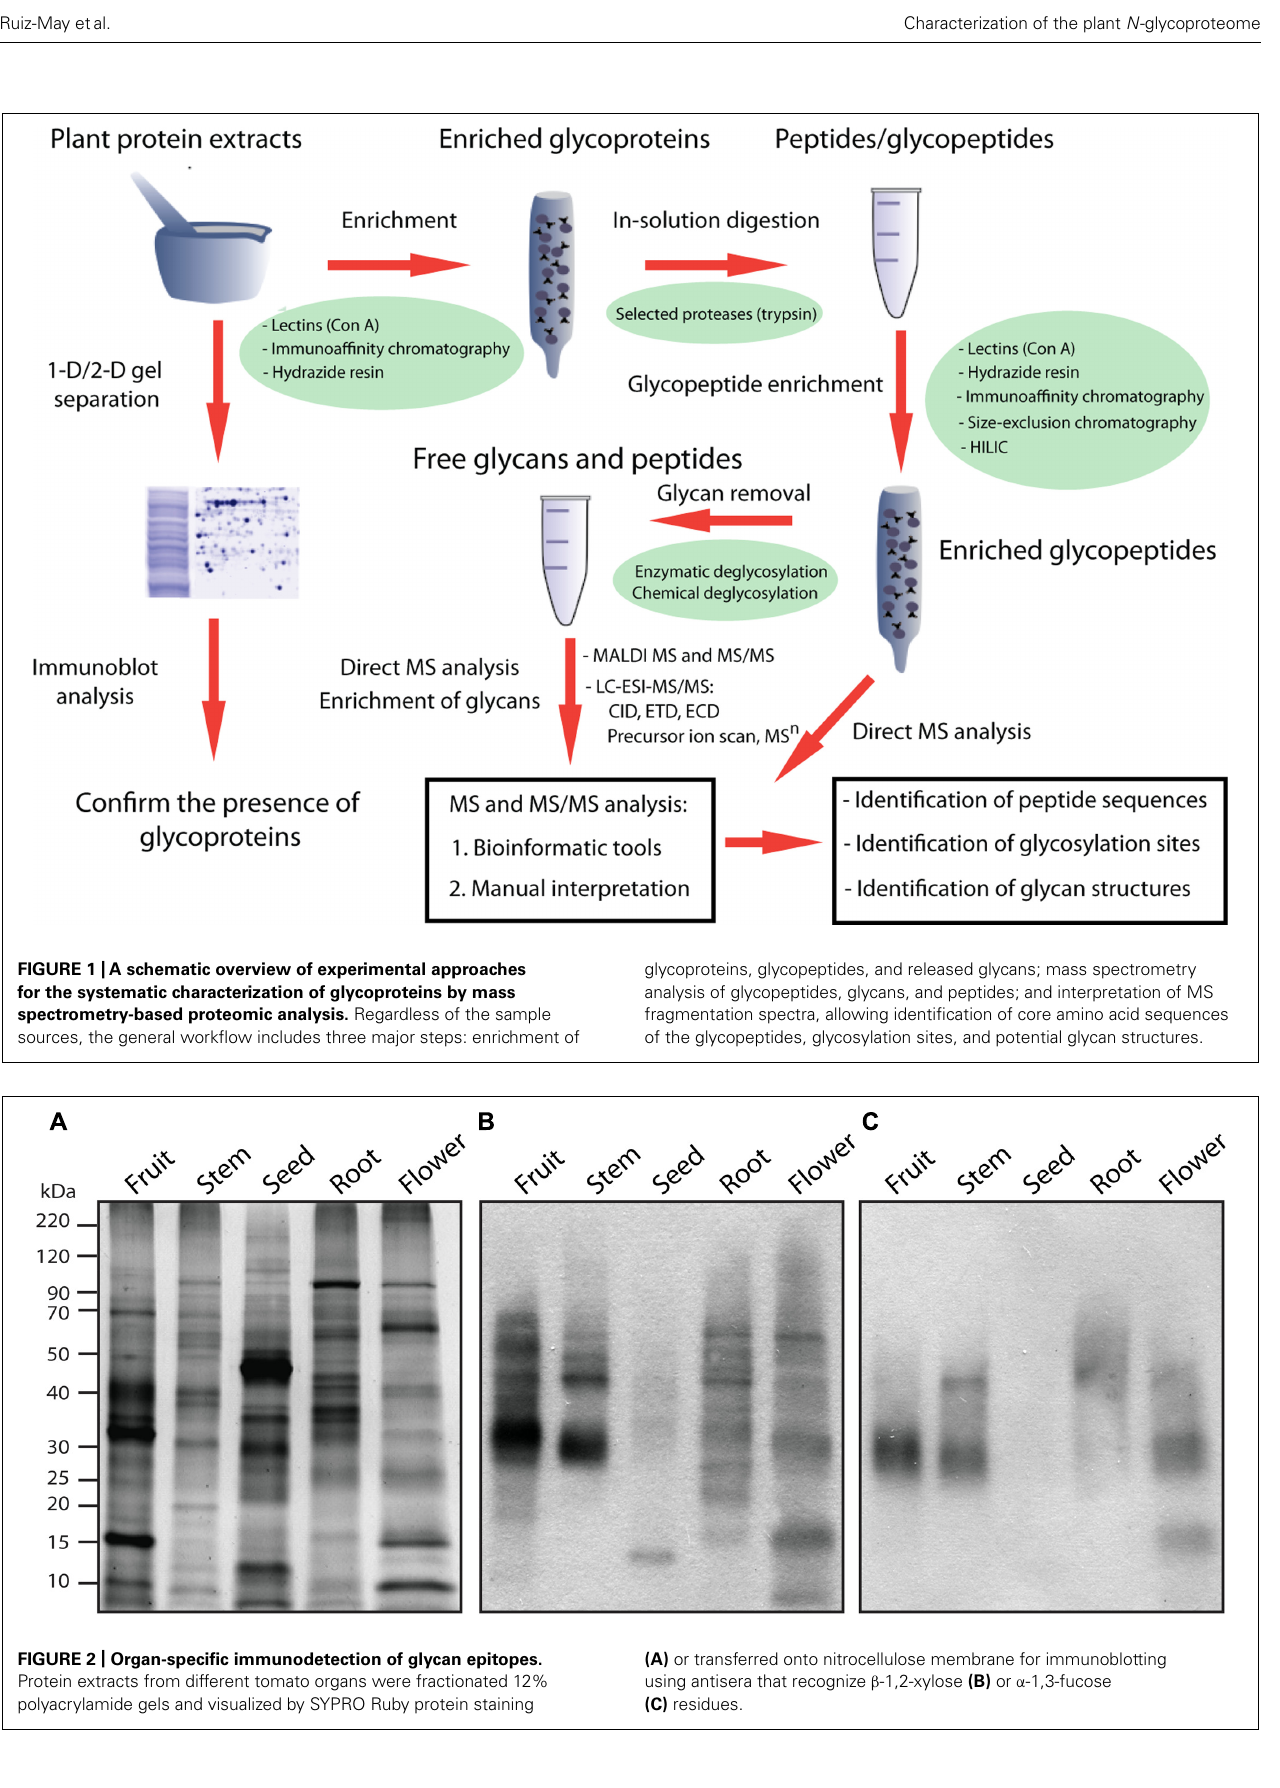
FIGURE 2 | Organ-specific immunodetection of glycan epitopes. Protein extracts from different tomato organs were fractionated 12% polyacrylamide gels and visualized by SYPRO Ruby protein staining